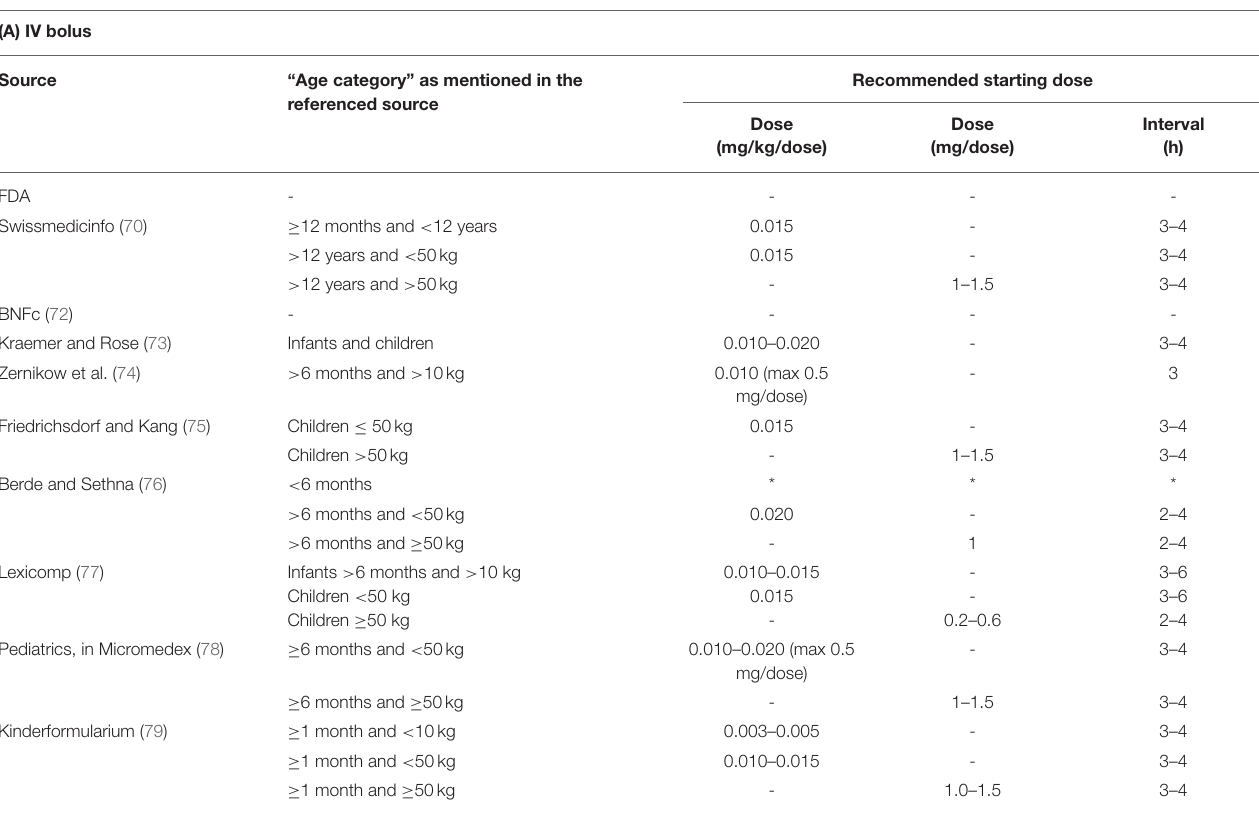
TABLE 3 | Examples of pediatric dosing